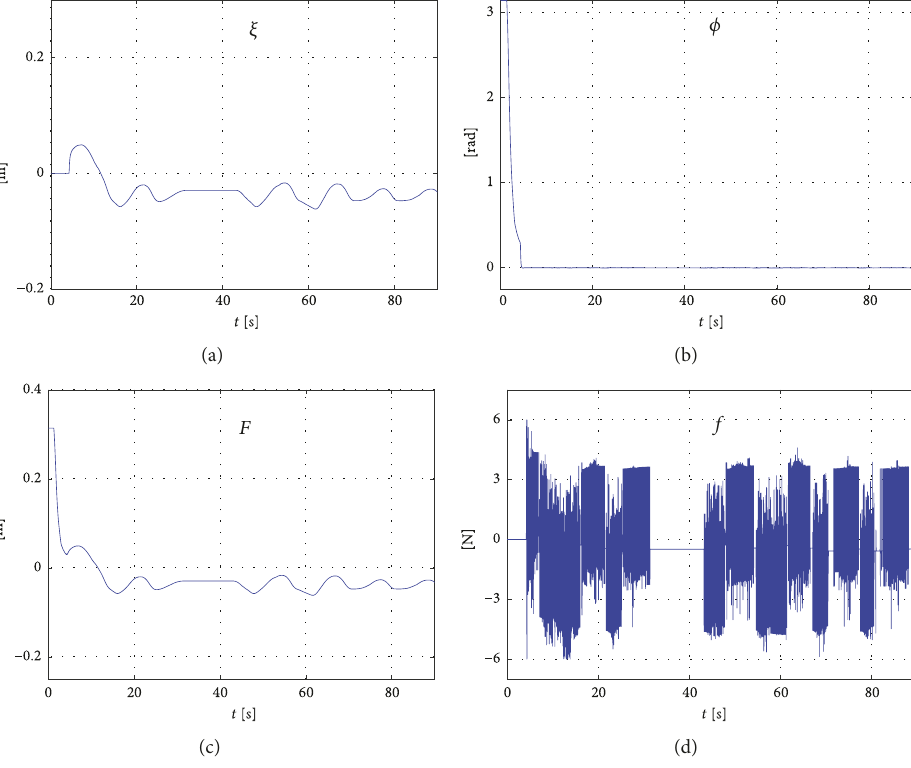
Figure 13: Experimental results when |𝐺(𝑗𝜔 𝜎 )| = 34 and 𝜔 𝜎 = 8 rad /